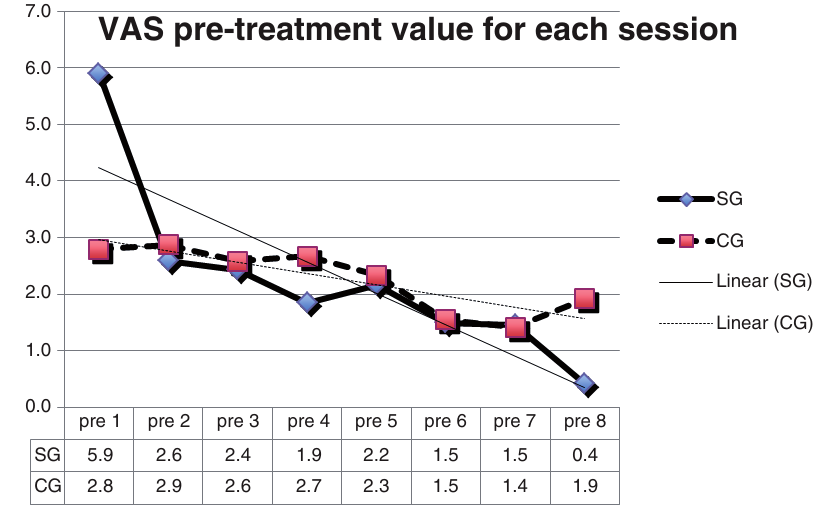
Figure 2. VAS values pre-treatment for each treatment session.